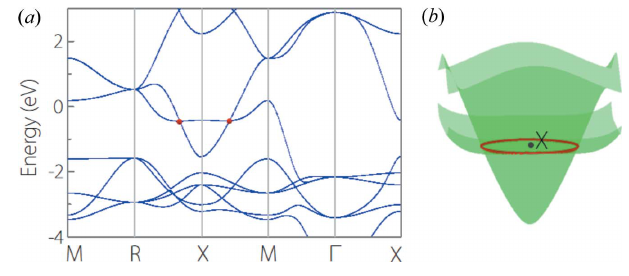
Figure 9 ( a ) Electronic band structure of CaPd. ( b ) Energy dispersion of the two crossing bands in ( a ). The red circle shows the critical-type nodal line in CaPd.